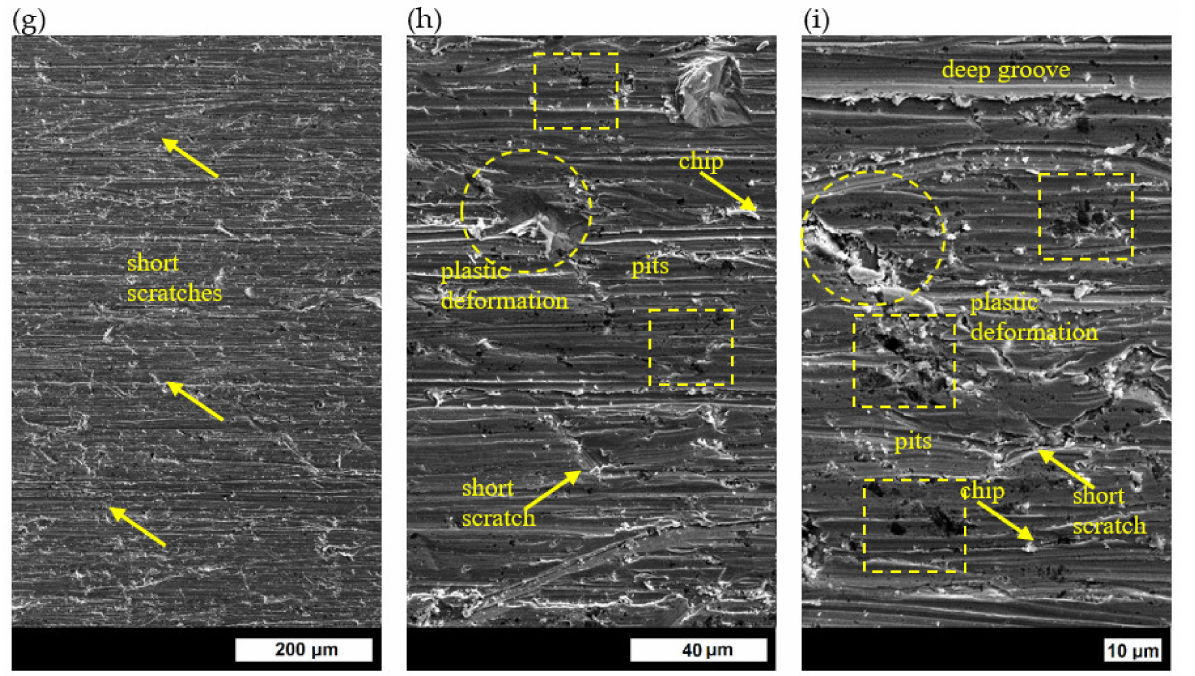
Figure 15. Wear surface of ingot No. 3 after quenching and tempering: ( a ) at 200 ◦ C, 600 × ; ( b ) at 200 ◦ C, 3000 × ; ( c ) at 200 ◦ C, 5000 × ; ( d ) at 400 ◦ C, 600 × ; ( e ) at 400 ◦ C, 3000 × ; ( f ) at 400 ◦ C, 5000 × ; ( g ) at 600 ◦ C, 600 × ; ( h ) at 600 ◦ C, 3000 × ; ( i ) at 600 ◦ C, 5000 × . Unetched,